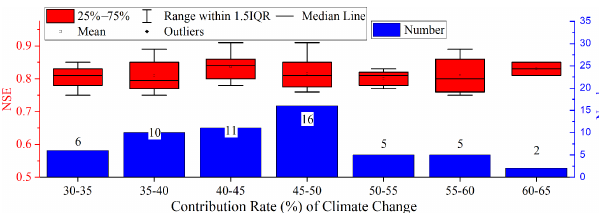
Figure 15. Histogram of the number of simulations of the CR (with 5% steps) of climate change to streamflow reduction in the LR basin at the annual scale and corresponding Nash–Sutcliffe effi- ciency box plots after excluding the parameter combinations. Table 9. Areas (km 2 ) of land use types in the LR basin in 1980, 1990, 2000, 2010, and 2015.